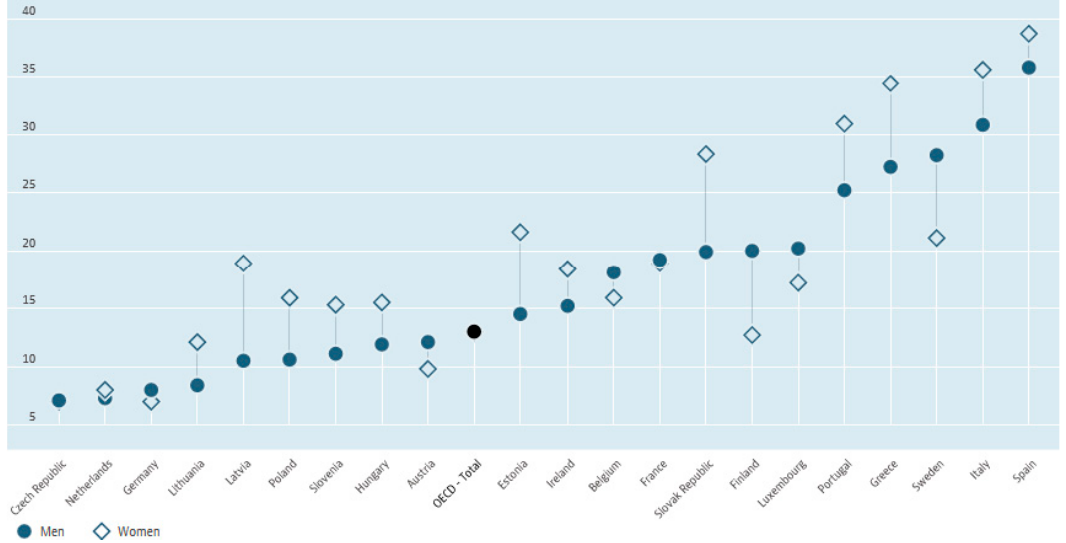
Figure 1. Youth unemployment rate 2021 by country in %. Source: OECD (2021a). Tamesberger and Bacher (2020) have also made calculations on the share of NEETs. They forecast that the NEET rate in Europe will be historically high, ranging between 14% (optimistic scenario) and 15.2% (pessimistic scenario). According to the OECD, gender differences also occurred in 2019: in the Czech Republic, Poland, Portugal, and Hungary, the most vulnerable group among NEETs is young women aged 20–24. On the other